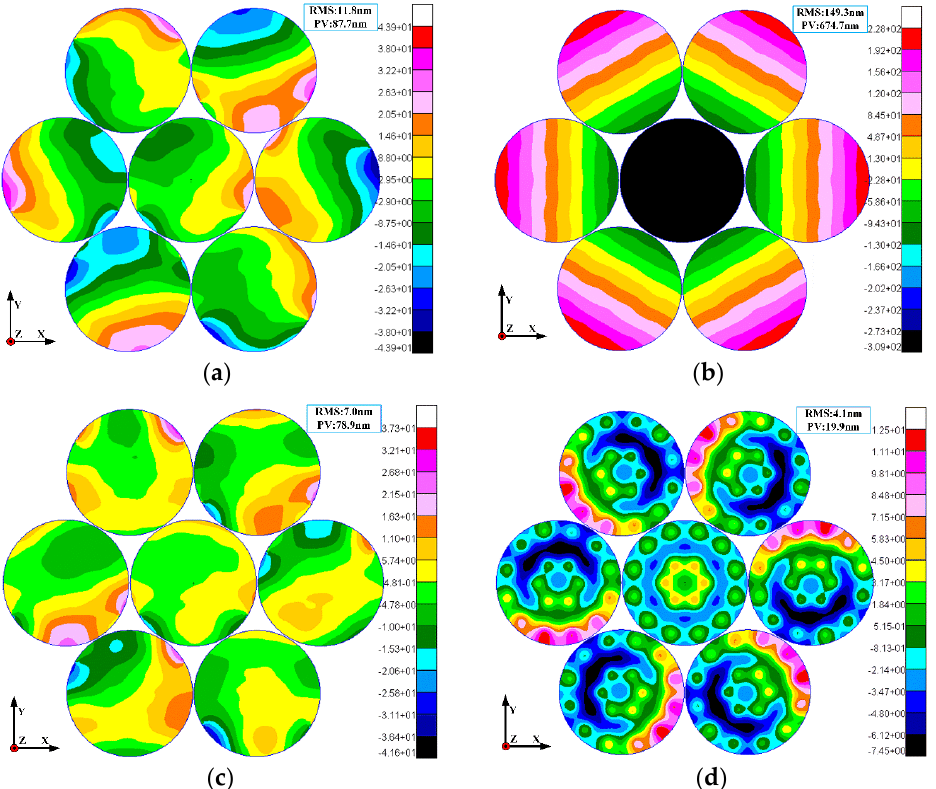
Figure 5. Zerodur segment segmented mirror surface after correction by two schemes, ( a ) Scheme 1, deformation of mirror surface in Y condition, ( b ) Scheme 1, deformation of mirror surface in Z condition, ( c ) Scheme 2, deformation of mirror surface in Y condition, ( d ) Scheme 2, deformation of mirror surface in Z condition.